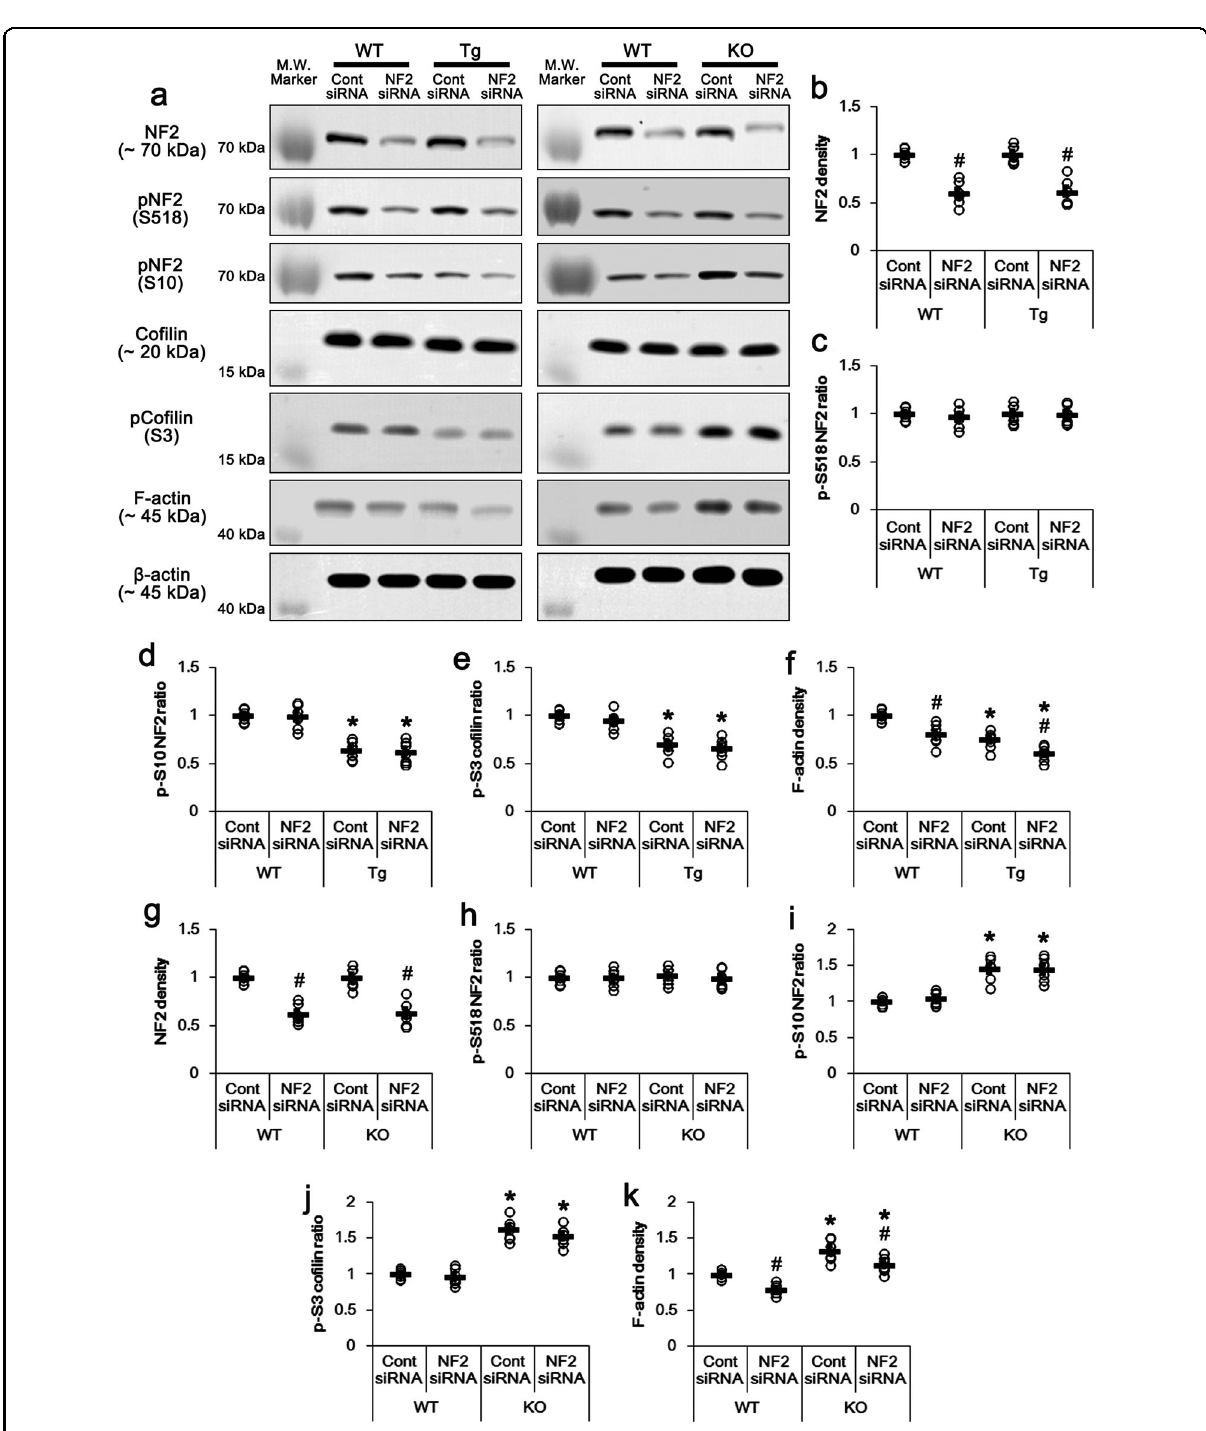
Fig. 4 Effects of NF2 knockdown on NF2 and co fi lin phosphorylations in PLPP/CIN Tg and PLPP/CIN − / − mice under physiological condition. a Representative western blots of NF2, pNF2-S10, pNF2-S518, co fi lin, pCo fi lin-S3, and F-actin. b – k Quanti fi cation of NF2, pNF2-S10, pNF2-S518, co fi lin, pCo fi lin-S3, and F-actin levels based on western blot data. Open circles indicate each individual value. Horizontal bars indicate mean value (* ,# p < 0.05 vs. WT and control siRNA-treated animals, respectively; n =